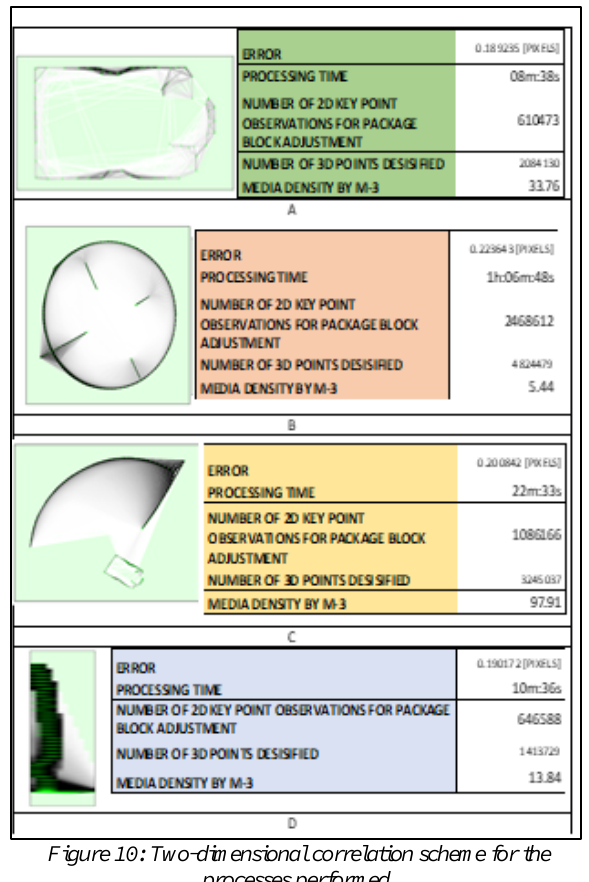
Figure 10: Two-dimensional correlation scheme for the processes performed.